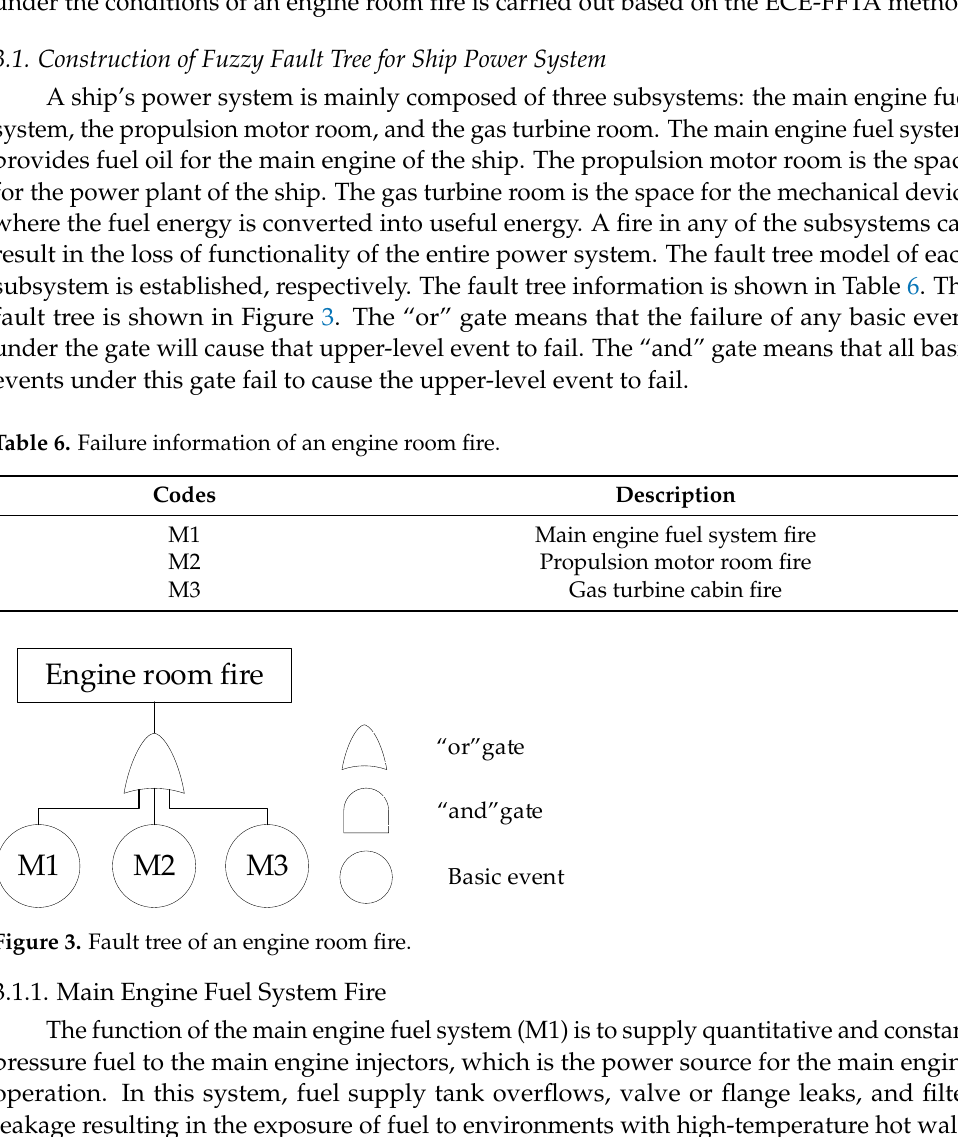
Table 5. The divisions of the safety risk grades.